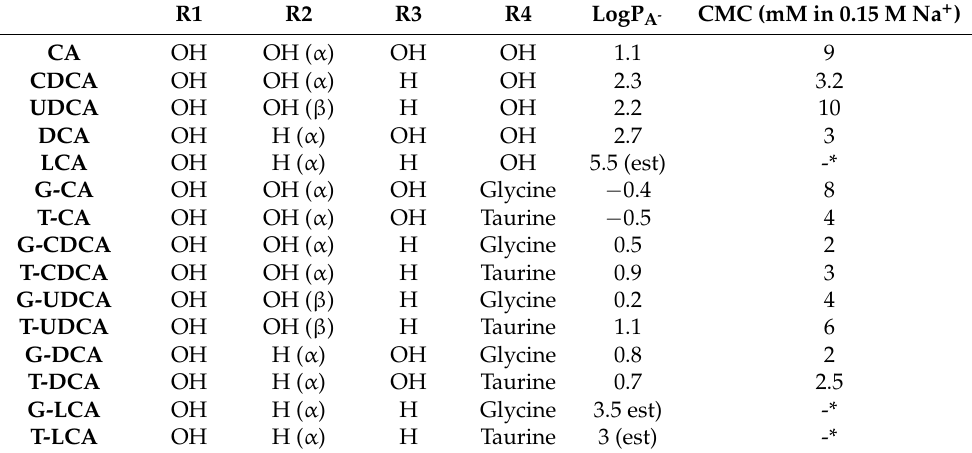
* do not self-aggregate due to their low water solubility; est: estimated; LogP A - : octanol/water partition coefficient of the ionized form; CMC: critical micellar concentration of the bile salt in Na + 0.15 M. T: taurine. G: